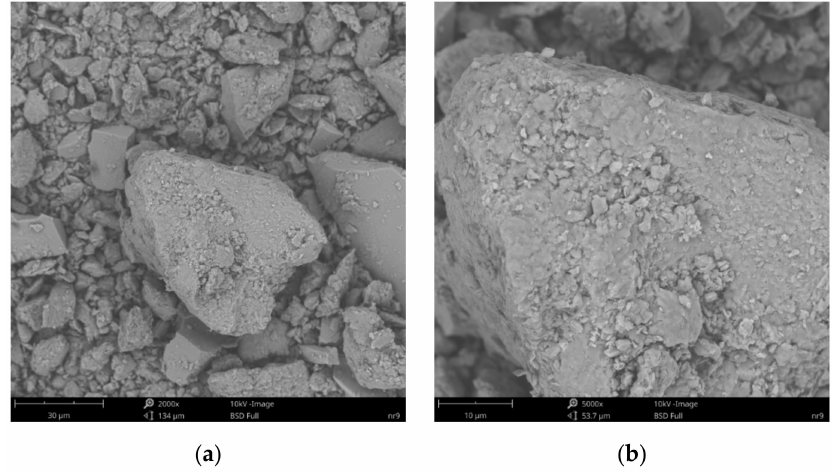
Figure 11. SEM images of particle surfaces for ( a ) SN-Na/25PAA, magnification: 2000 × , scale bar: 30 µ m; ( b ) SN-Na/25PAA, magnification: 5000 × , scale bar: 10 µ